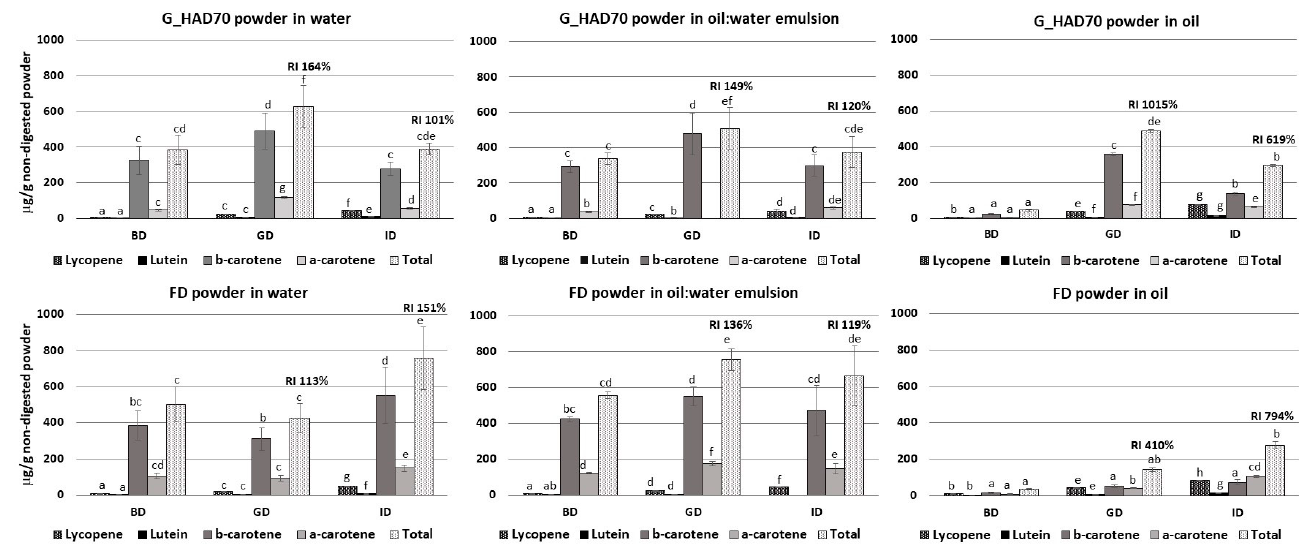
Figure 2. Total and individual carotenoid content (µg/g of non-digested powder) of selected powders mixed with water, 10% oil-in-water emulsion, or oil. Values of undigested samples (before digestion (BD)) and digested ones (after the gastric (GP) and after the intestinal phase (IP)) are given. Recovery index (RI) for total carotenoids after the gastric and intestinal phases are given in percentage. G_HAD70: ground and air-dried at 70 °C, FD: ground and freeze-dried. Values plotted correspond to mean ± standard deviation of four measurements. a,b,c,d,e,f,g,h. Different superscript letters for a similar carotenoid and treatment (G_HAD70 or FD) indicate statistically significant differences at the 95% confidence level ( p -value < 0.05).